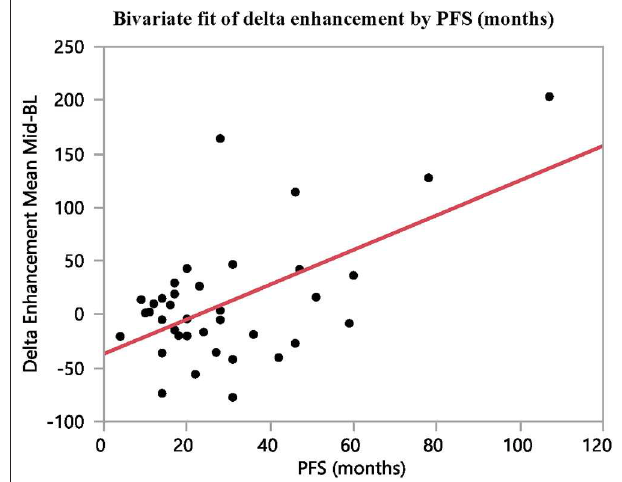
FIGURE 5 | The difference in contrast-enhancement during early stages of treatment (baseline to mid-treatment) correlates with PFS ( n = 37, R 2 = 0.33, p = 0.0002).